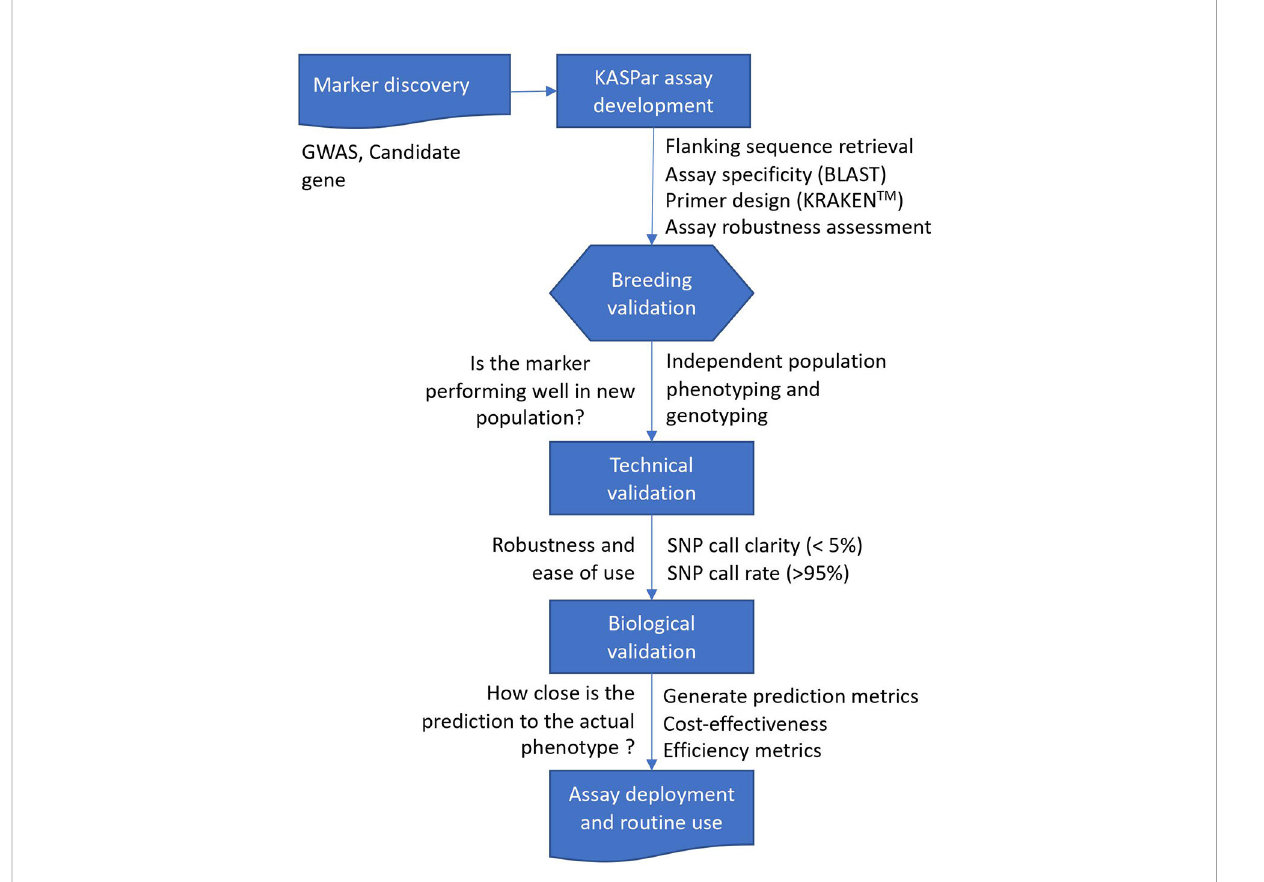
FIGURE 1 Schematic overview of marker discovery, assay development, and validation of trait-linked markers for molecular